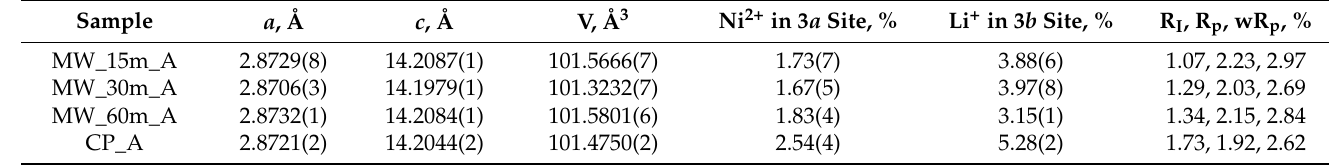
Table 1. Crystallographic data after the Rietveld refinement for the LiNi 0.8 Mn 0.1 Co 0.1 O 2